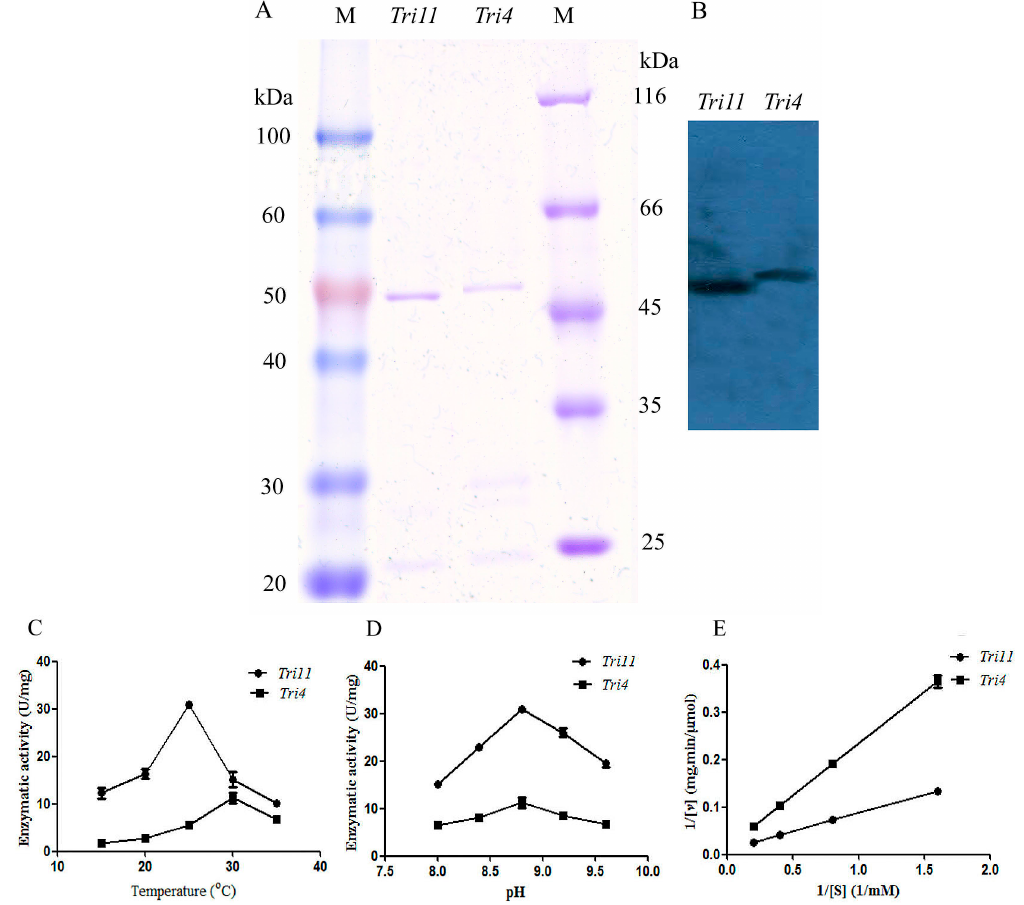
Figure 7. Identification of Tri4 and Tri11 genes: ( A ) the expression and purification of enzymes encoded by Tri4 (TRO-MR) and Tri11 (ITH-MR), M indicated protein marker; ( B ) the Western blot analysis of TRO-MR and ITH-MR using anti-His monoclonal antibody; ( C ) the optimal reaction temperatures of TRO-MR and ITH-MR; ( D ) the optimal reaction pH values of TRO-MR and ITH-MR; and ( E ) the enzymatic kinetics of TRO-MR and ITH-MR, the K m and V max values were calculated.